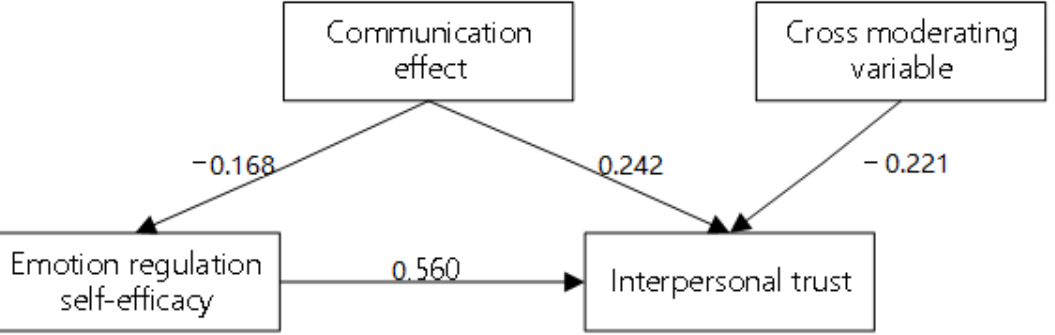
Figure 5. The moderating role of moral consciousness between emotional regulation self-efficacy and interpersonal